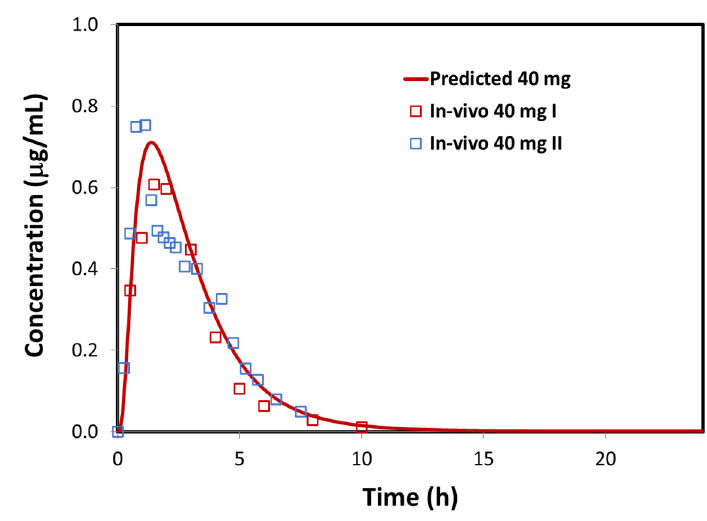
GastroPlus™ default values for stomach, duodenum, jejunum 1, jejunum 2, ileum 1, ileum 2, ileum 3, caecum, and ascendant colon